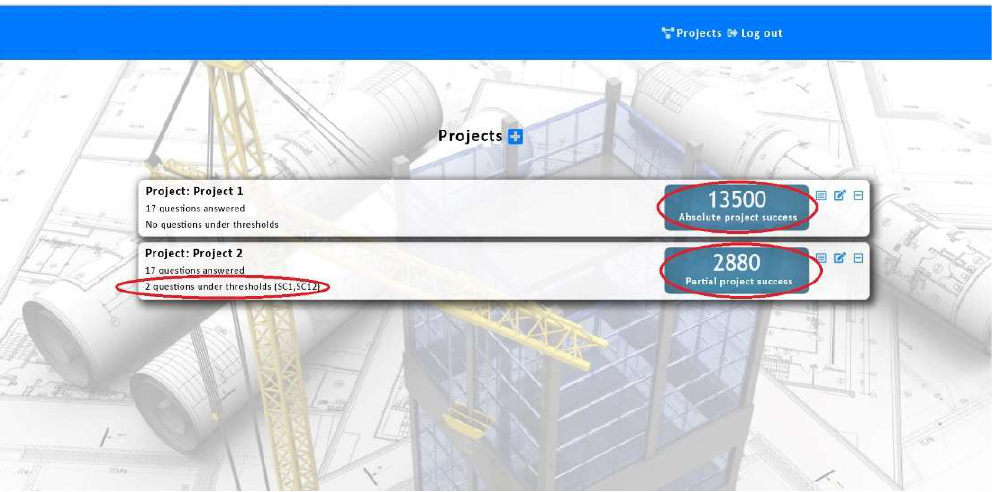
Figure 3. The Project Success Score and the potential success criteria under thresholds.